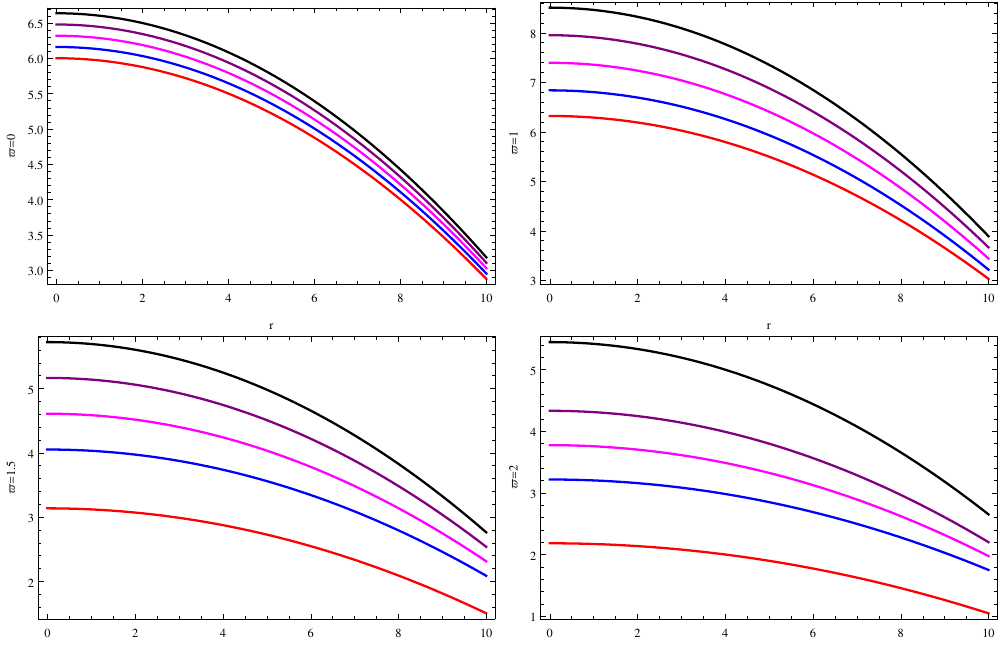
different values of coupling matter geometry parameter (cid:118) for our anisotropic fluid model absence of which GR features can be retrieved.